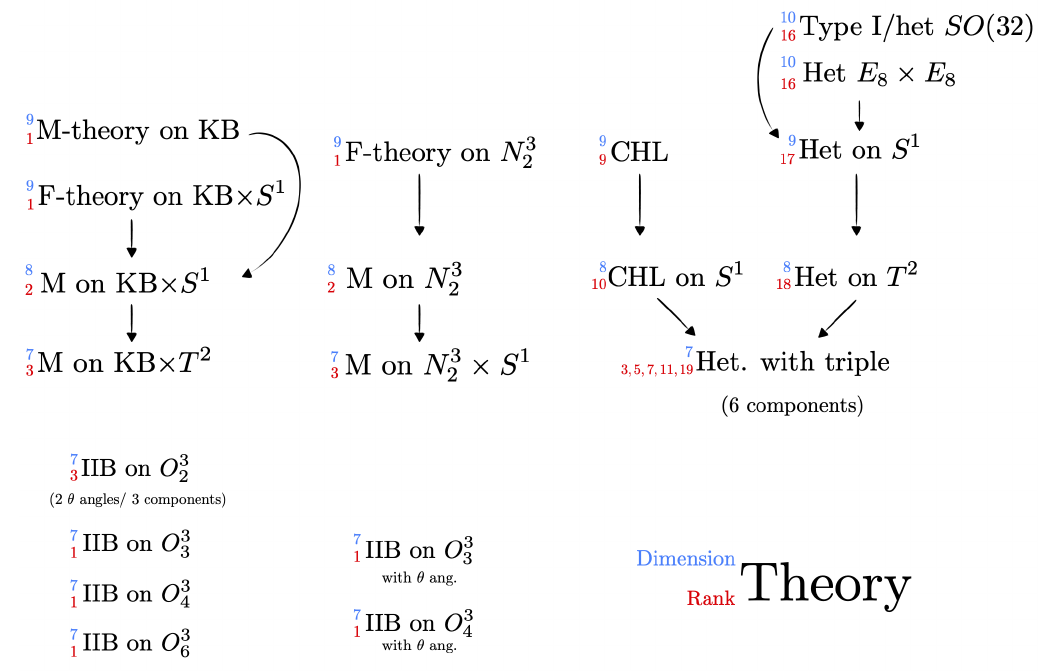
Figure 5 . List of all known disconnected theories with 16 supercharges in dimension ≥ 7 . We label each component of moduli space by a representative compactification (e.g. heterotic on S 1 ); we do not list all dual descriptions (e.g. CHL ∼ M on Möbius strip). Theories connected by an arrow are related by dimensional reduction. For each component we indicate both the dimension (upper left blue number) and the rank (lower left red number), in a manner meant to be reminiscent of the periodic table of